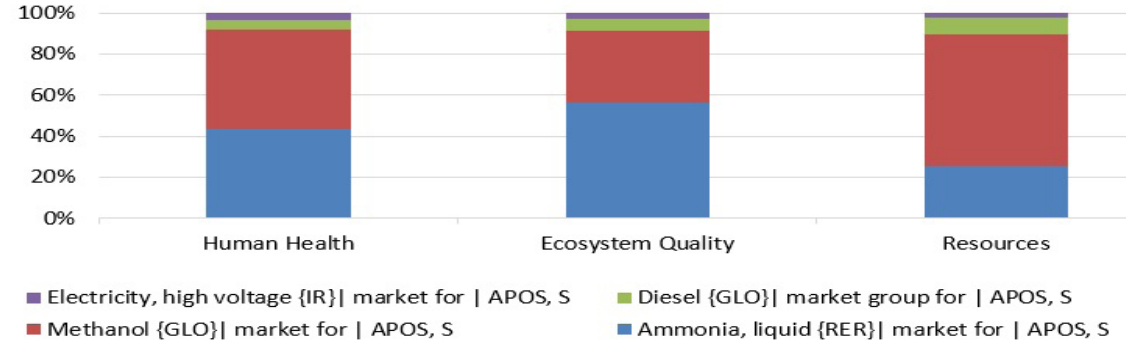
Figure 3. Results of applying the Eco-indicator 99 method in damage calculation